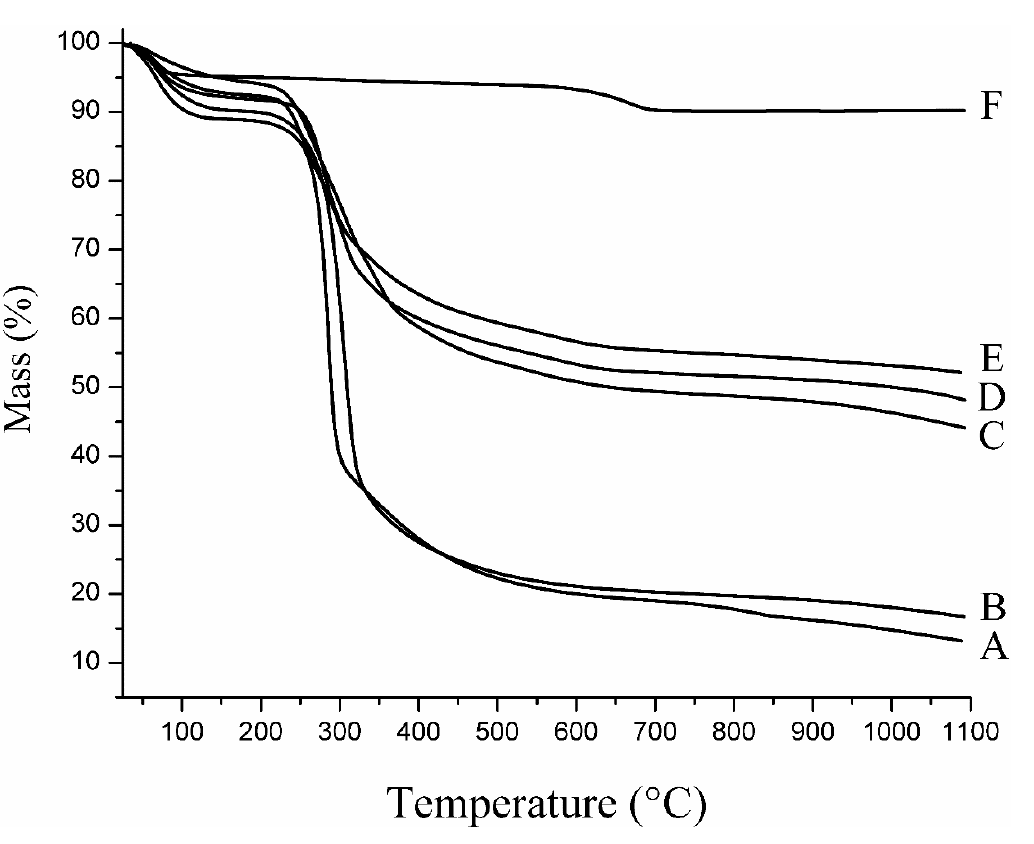
Figure 7. TG traces of ( A ) CG; ( B ) NG; ( C ) NG-MMT 6:1; ( D ) NG-MMT 3:1; ( E ) CG-MMT 3:1; and ( F ) Na +